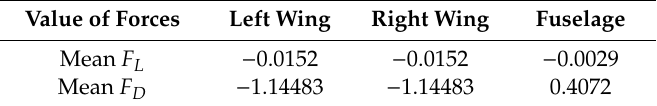
Table 1. Mean values of the lift and drag forces of twin wings and